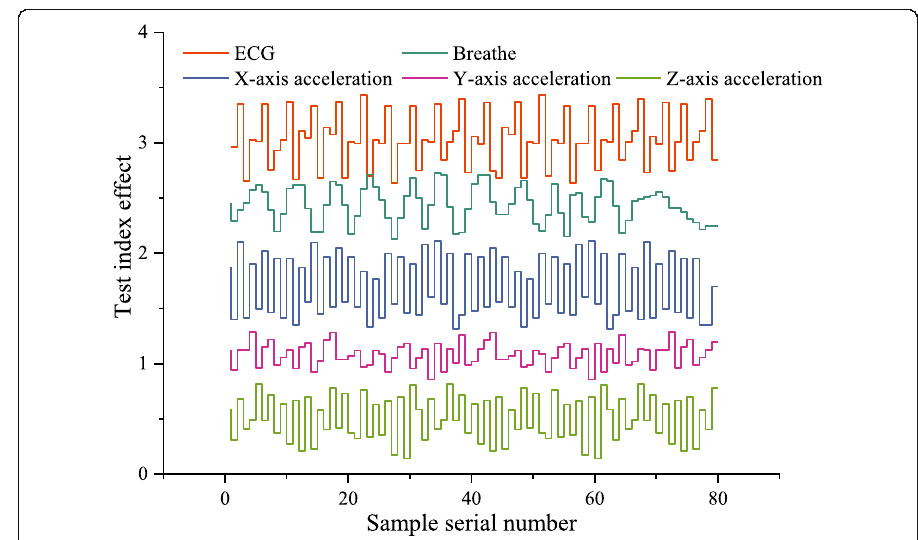
Fig. 8 Test values of cardiopulmonary physiological signals — exercise intensity 10